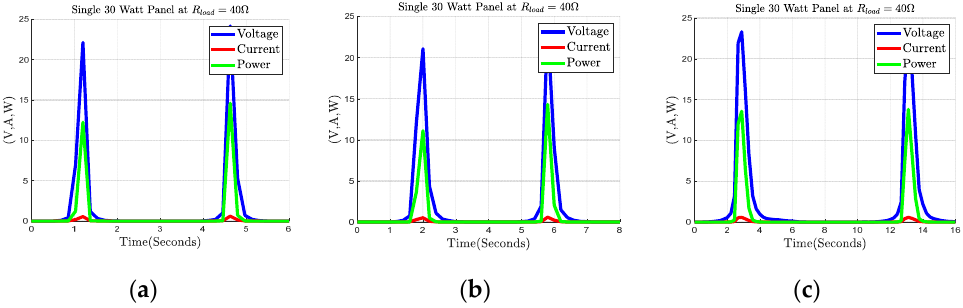
Figure 13. Output voltage, current, and power measured while simulated vehicle in motion using the 30 W Renogy ® solar panel and under different speeds (1.12 m/s ( a ), 2.24 m/s ( b ) and 3 m/s ( c ), from left to right respectively).